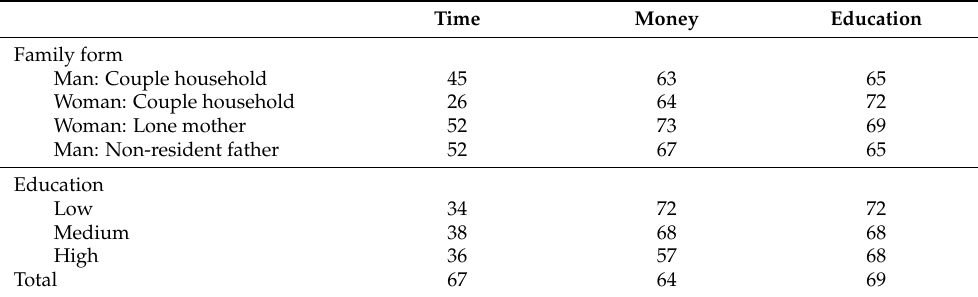
Table 2. Concerns about having too little time for children (TIME), concerns that financial require- ments have increased (MONEY), concerns that educational requirements have increased (EDUCA- TION), in